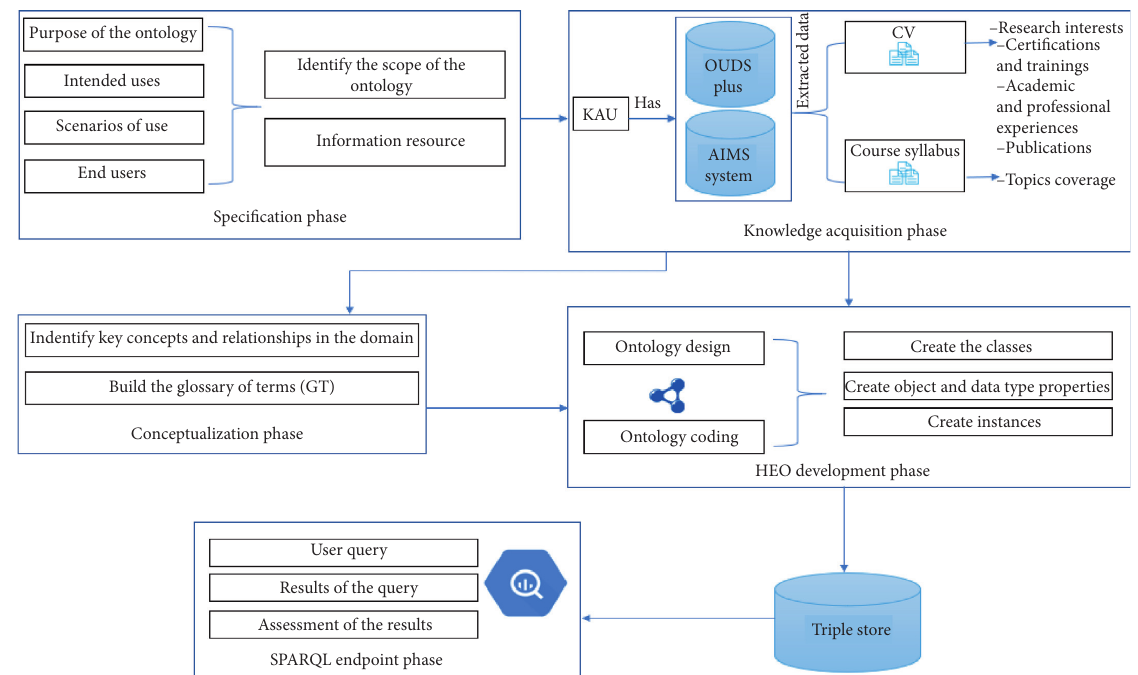
Figure 1: The architecture of the Higher Education Activities and Processes Automation Framework (HEAPAF).